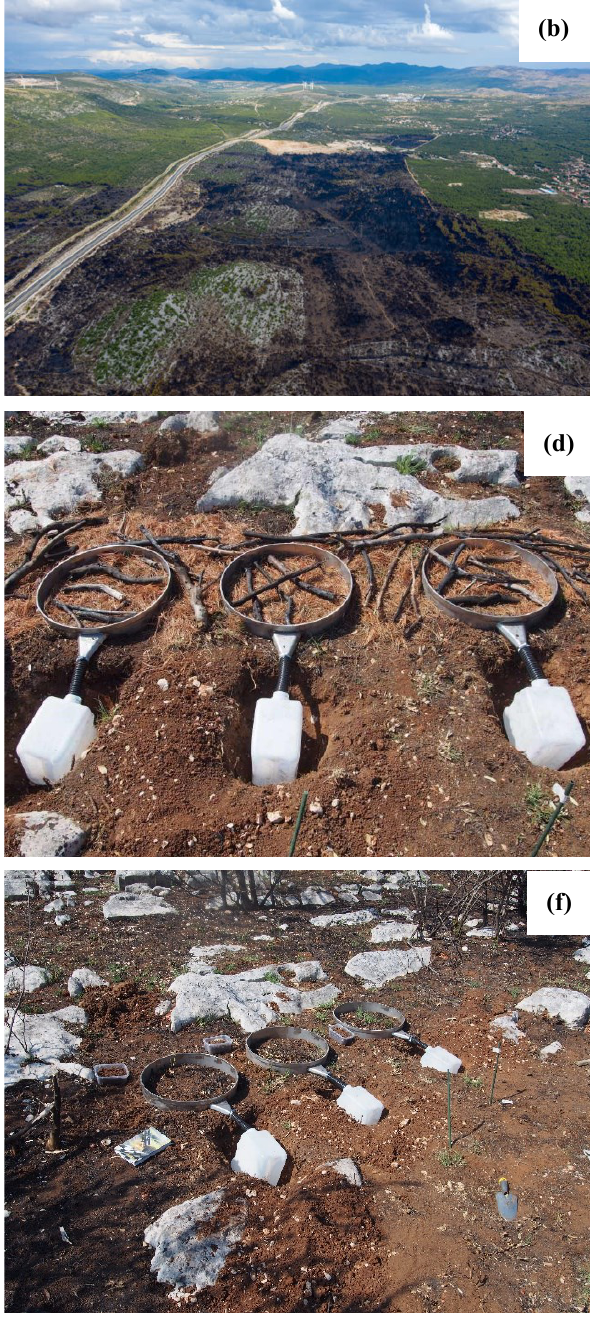
Figure 2. Aerial photographs of the wildfire-affected area ( a , b ); party burned vegetation canopy of the study site (25 days after fire) ( c ); Pinus halepensis mulch treatment (PM) ( d ); Olea europaea mulch treatment (OM) ( e ); unmulched burned soil (UM) ( f ).